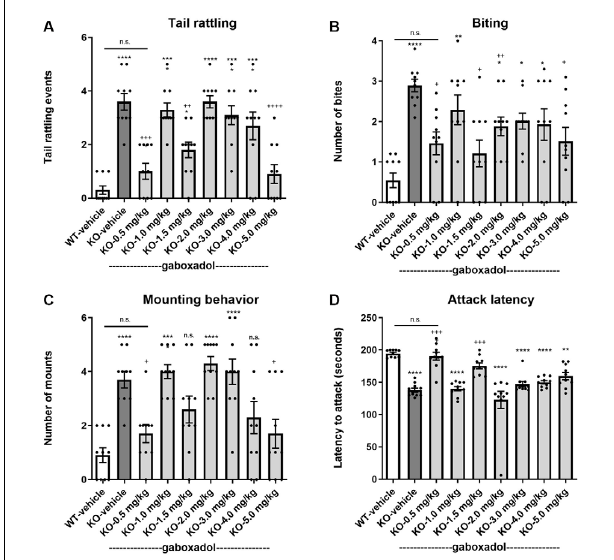
FIGURE 3 | Gaboxadol normalizes irritability and aggression behaviors in Fmr1 KO2 mice. Tail rattling (A) , biting behavior (B) , mounting behavior (C) and latency to attack a novel cage-mate (D) were measured in WT mice treated with vehicle (white bar), Fmr1 KO2 mice treated with vehicle (KO, dark gray bar), or Fmr1 KO2 mice treated with gaboxadol (KO-0.5–5.0 mg/kg, light gray bars). Bars are means ± SEM, dots are raw data from individual mice. ∗∗∗∗ p < 0.0001, ∗∗∗ p < 0.001, ∗∗ p < 0.01, ∗ p < 0.05 vs. WT-vehicle